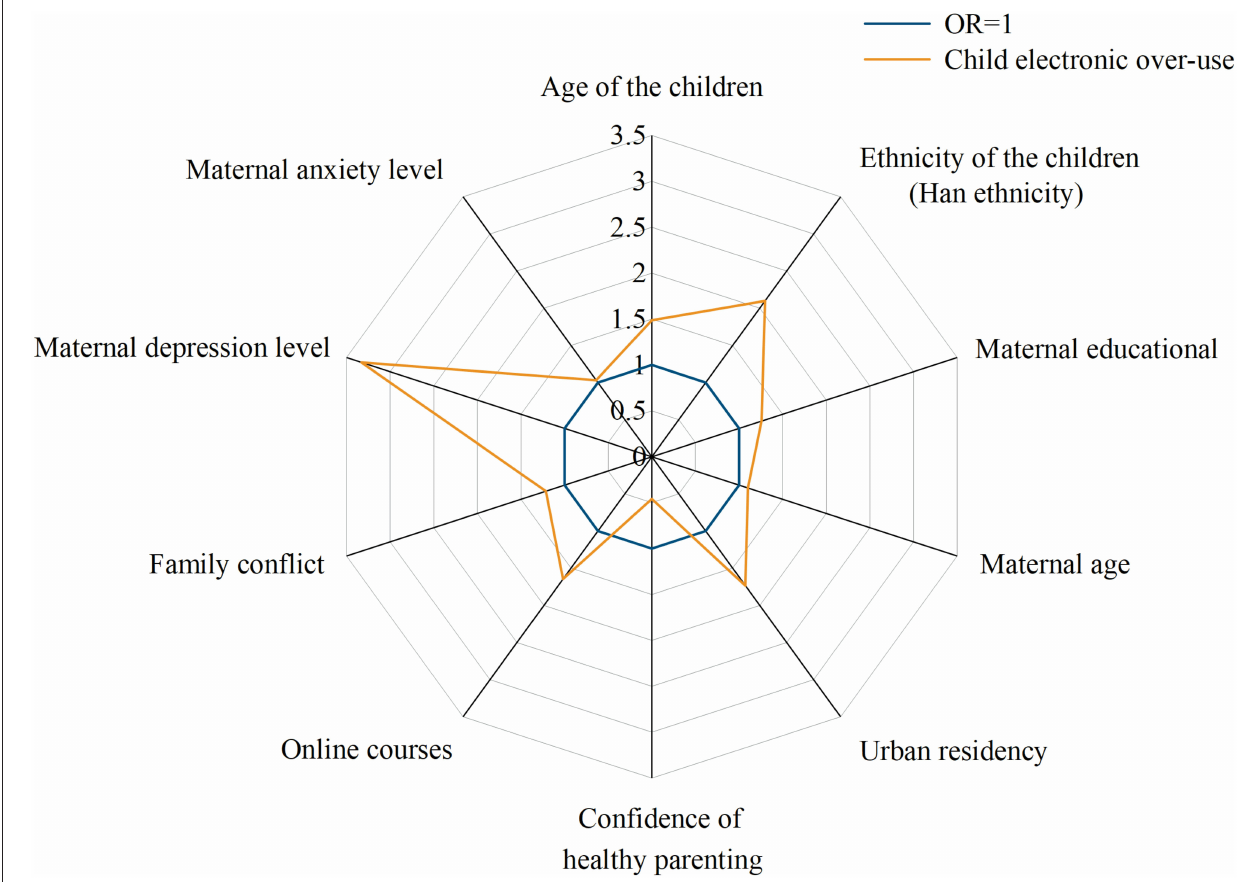
FIGURE 2 | Risk factors for child over-use of electronic devices. Child over-use of electronic devices was positively associated with child age, ethnicity (Han ethnicity), maternal education, maternal age, home urban residency, taking online courses, family conflict levels, maternal depression, and anxiety levels. Child over-use was negatively associated with maternal confidence of healthy parenting during the